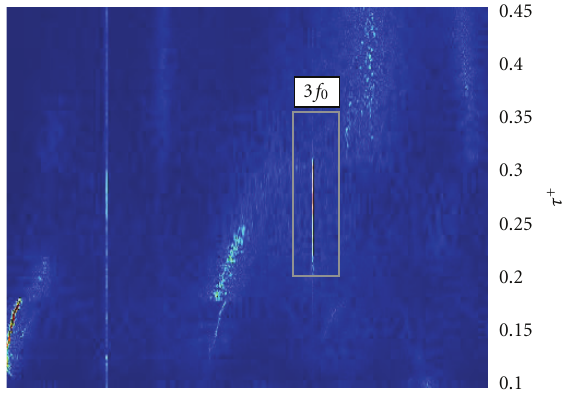
Figure 12: Extended waterfall plot of F y ( Q n , N ref ).